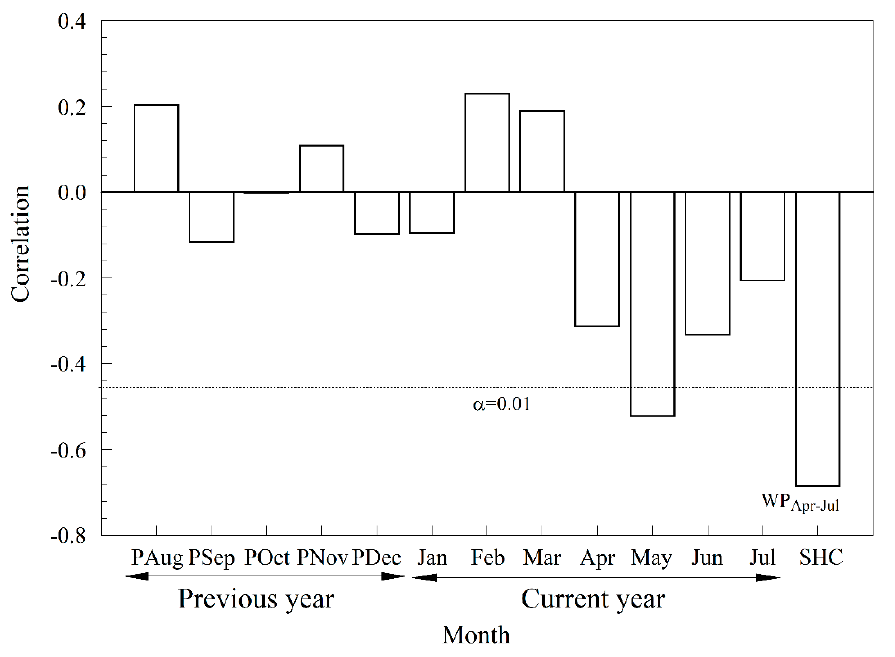
Figure 9. Correlation between the western Pacific (WP) regional teleconnection patterns and the CNDVI JJ . SHC indicates season with the highest correlation.